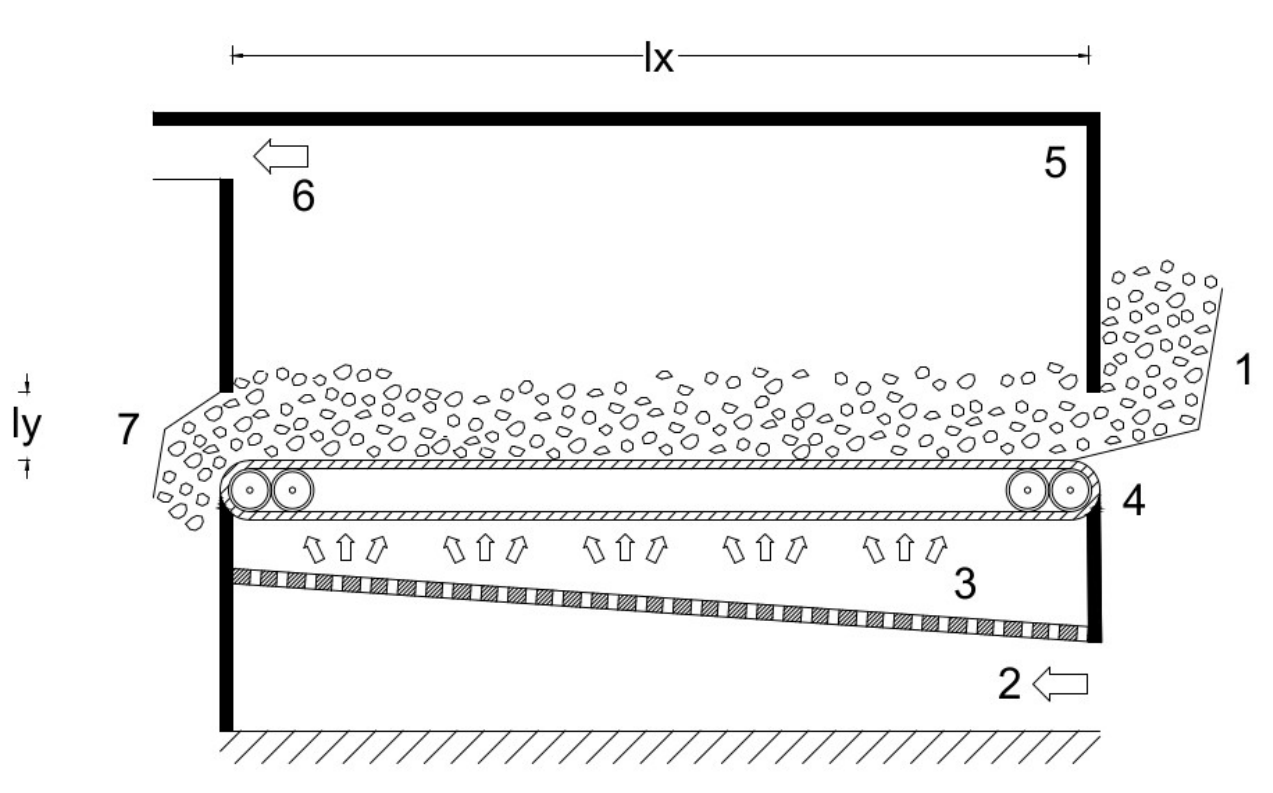
Figure 1. Fluidized bed drying chamber: (1) product inlet; (2) air inlet; (3) air diffuser; (4) conveyor belt; (5) insulated wall; (6) air outlet; and (7) product